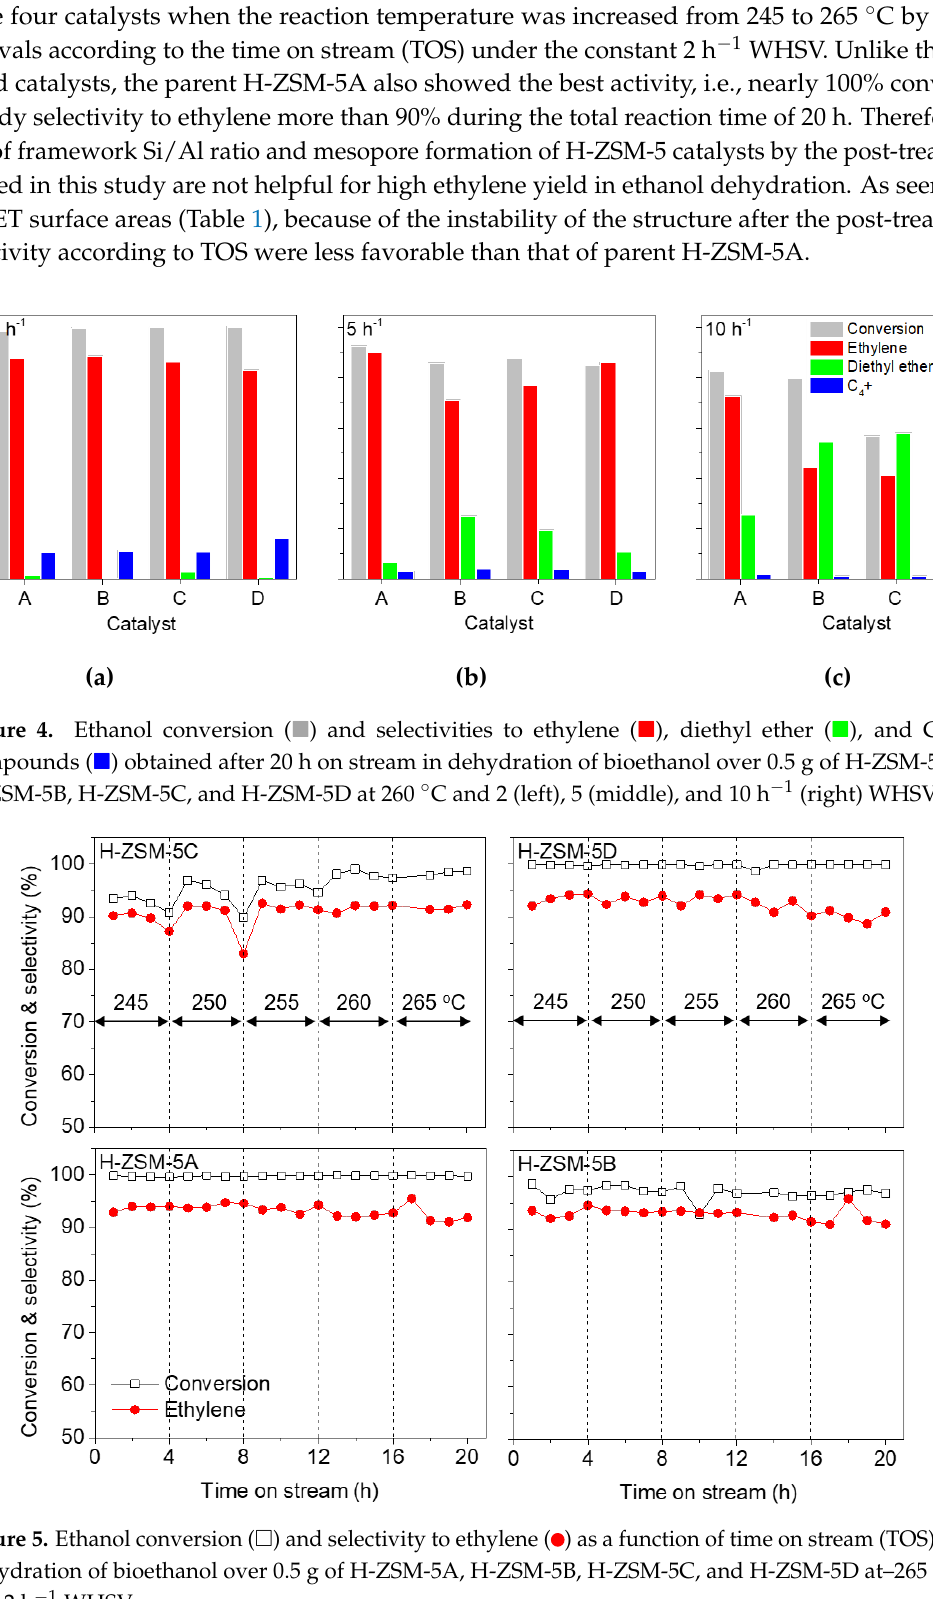
Figure 3. NH 3 TPD curves of H-ZSM-5A, H-ZSM-5B, H-ZSM-5C, and H-ZSM-5D.